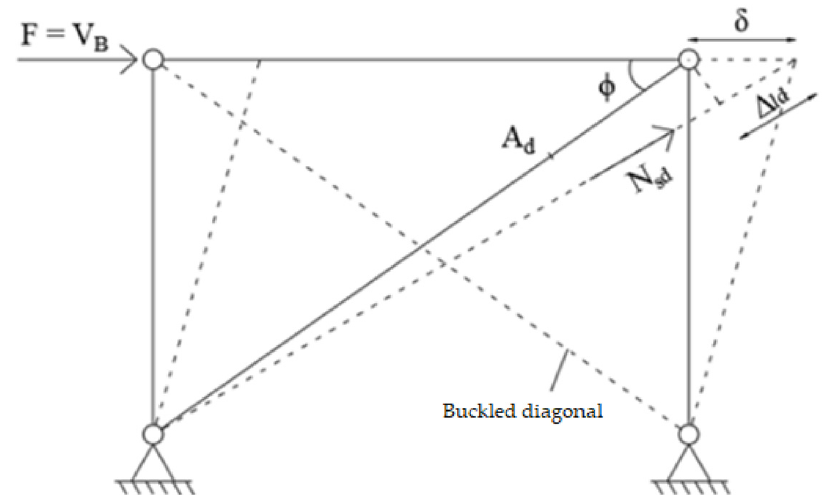
Figure 2. Calculation scheme for the second-phase stiffness K 2 .